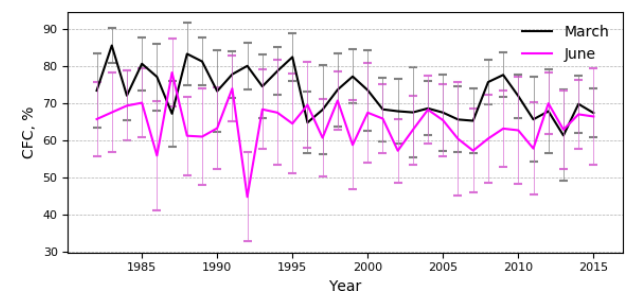
Figure 3. Comparison of monthly cloud fractions from Tõra- vere SYNOP station with satellite CFC of CLARA-A2, CLAAS-2, COMET in March 1982–2015 (or for the period